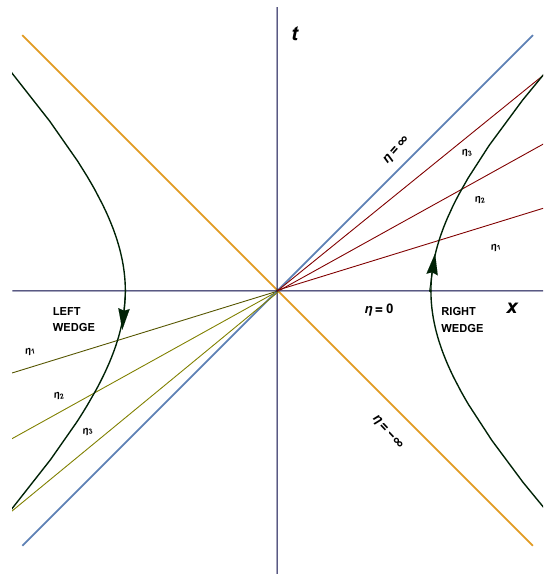
Figure 2 . Two dimensional Rindler space spanned by ( η, ξ ) coordinates, with the inertial set of coordinates being ( t, x ) . The timelike vector flows in opposite directions for two causally disconnected wedges (Right/Left), and the constant η timeslices η 1 < η 2 < η 3 are shown spanning both wedges. Constant ξ surfaces are families of hyperbolae corresponding to progressively accelerated